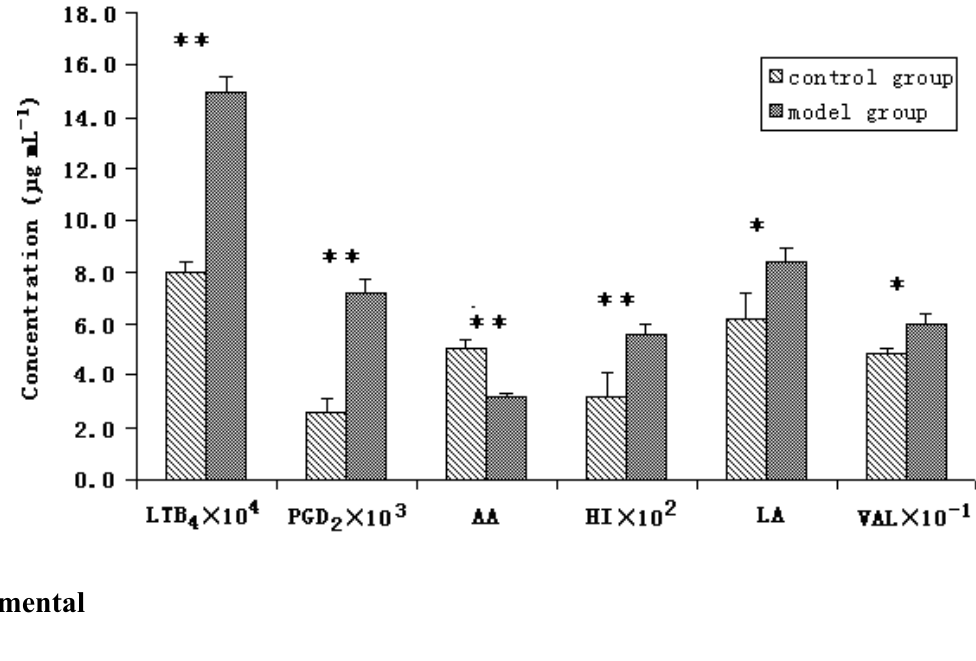
Figure 3. Concentration figure of the six endogenous substances in rat serum of the modal group and the control group. ** p < 0.01, * p <